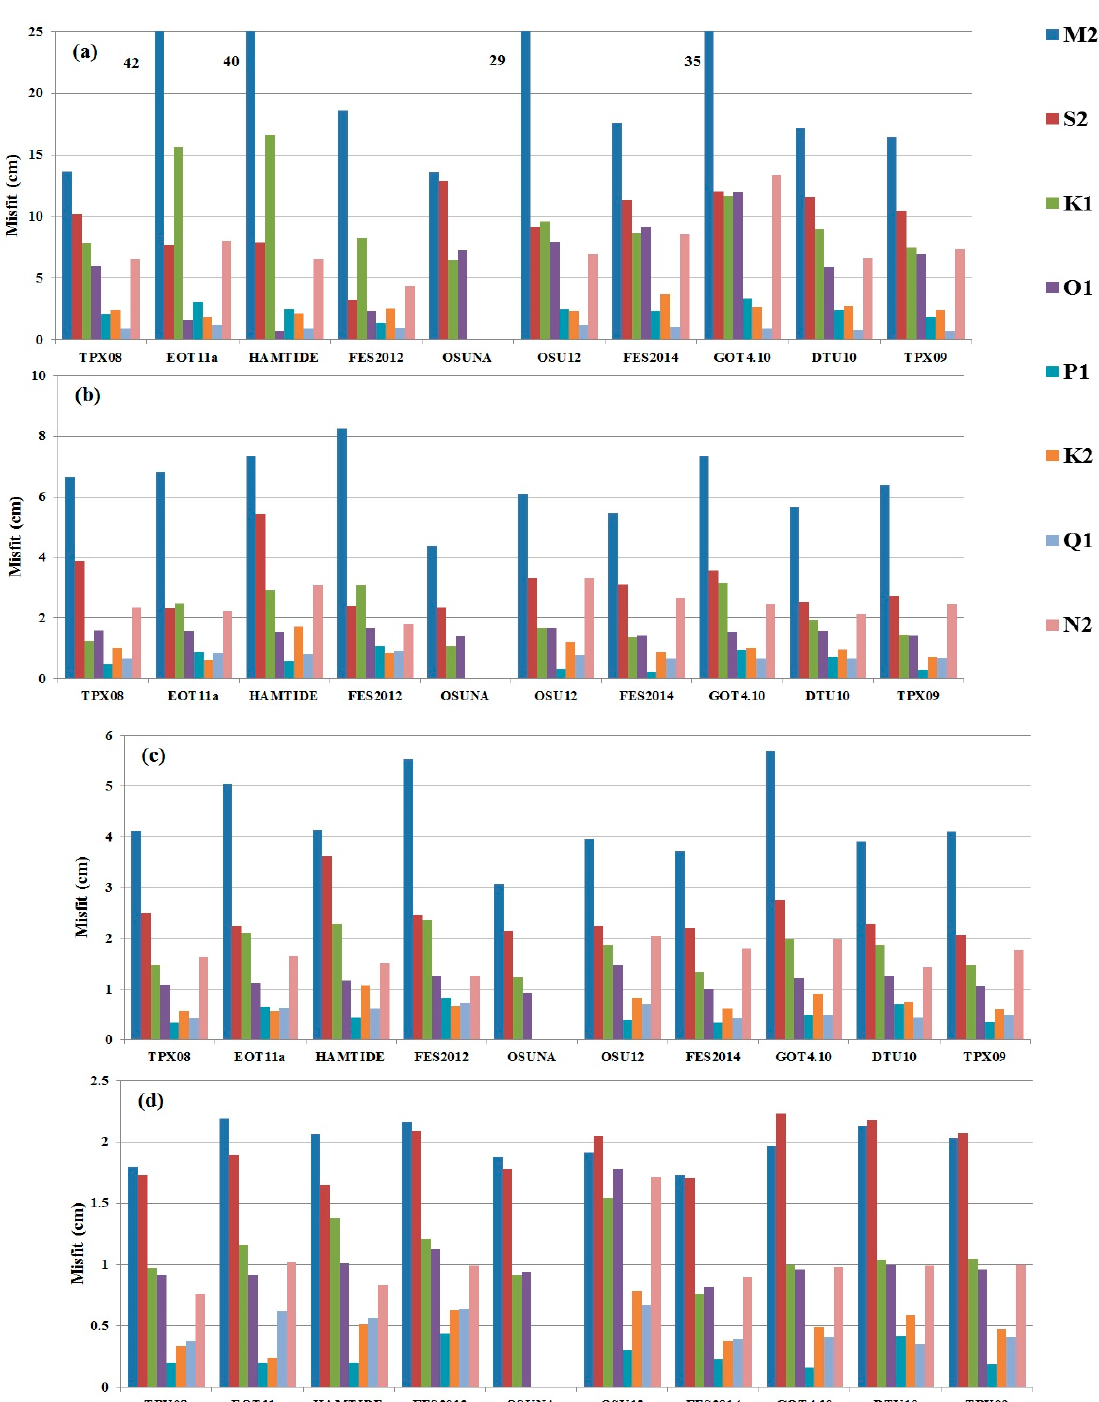
Figure 4. The mean RMS values of the differences between tidal major constants calculated for: coastline ( a ); coastal ( b ); shelf ( c ); and deep ocean ( d ) zone and tidal models (cm). The numbers in ( a ) show the RMS values greater than 25 cm.